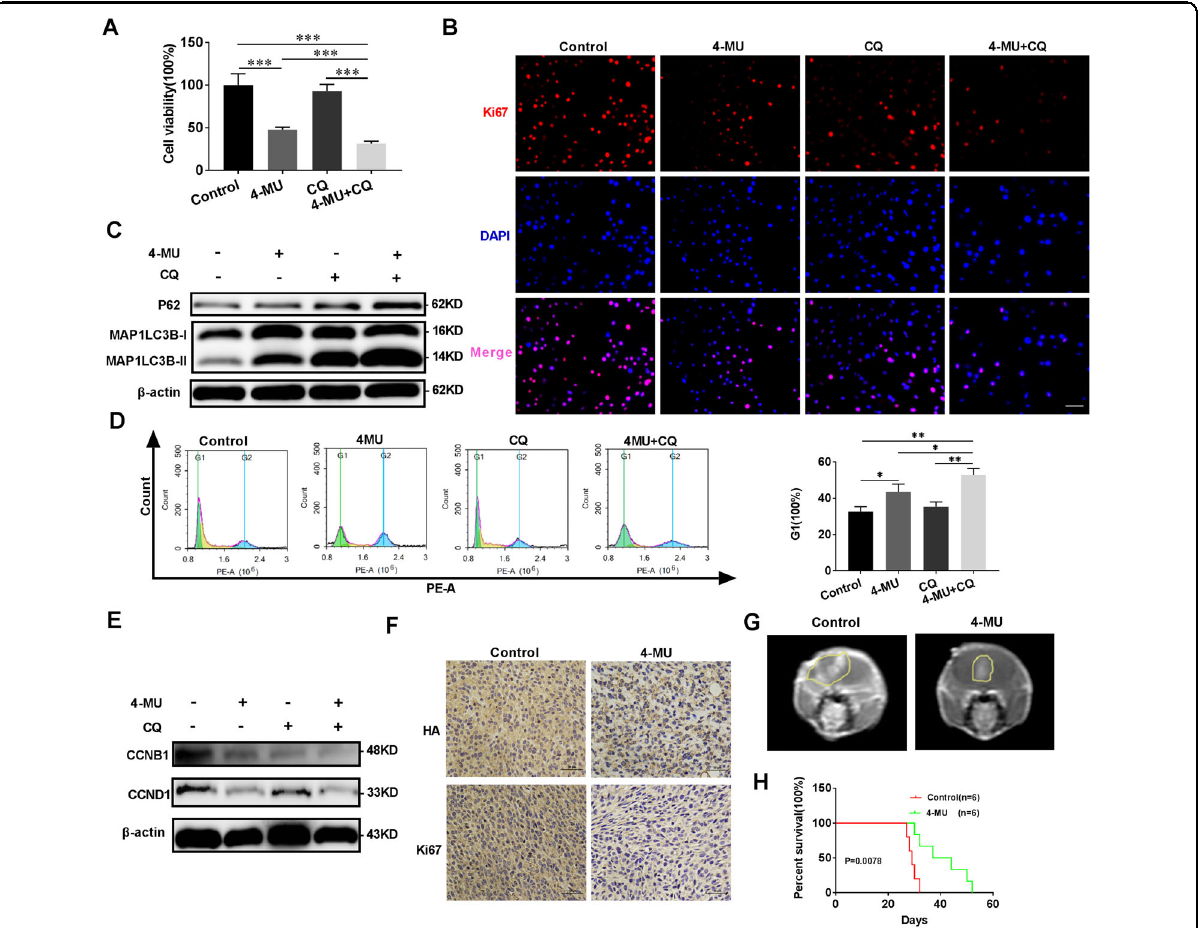
Fig. 7 4-MU inhibits glioma growth in vivo and, when combined with autophagy inhibitors, exerts synergistic effects on glioma cell viability, autophagy levels, and the cell cycle. A Viability of U251 glioma cells cultured with 4-MU, followed by treatment with CQ (30 μ mol/L) for 48 h. B Levels of the Ki67 protein in U251 glioma cells were detected using immuno fl uorescence staining after culture with 4-MU, followed by treatment with CQ (30 μ mol/L) for 48 h. C Relative levels of the P62 and MAP1LC3B proteins in U251 glioma cells cultured with 4-MU, followed by treatment with CQ (30 μ mol/L) for 48 h. Scale bar: 50 μ m. D The cell cycle distribution was detected in U251 glioma cells using fl ow cytometry